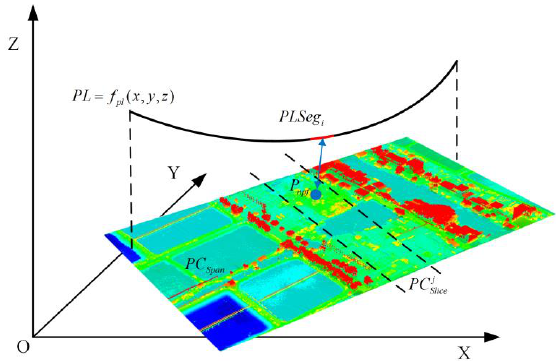
Figure 5. Piecewise clearance calculation of the power line and the non-power-facility objects.